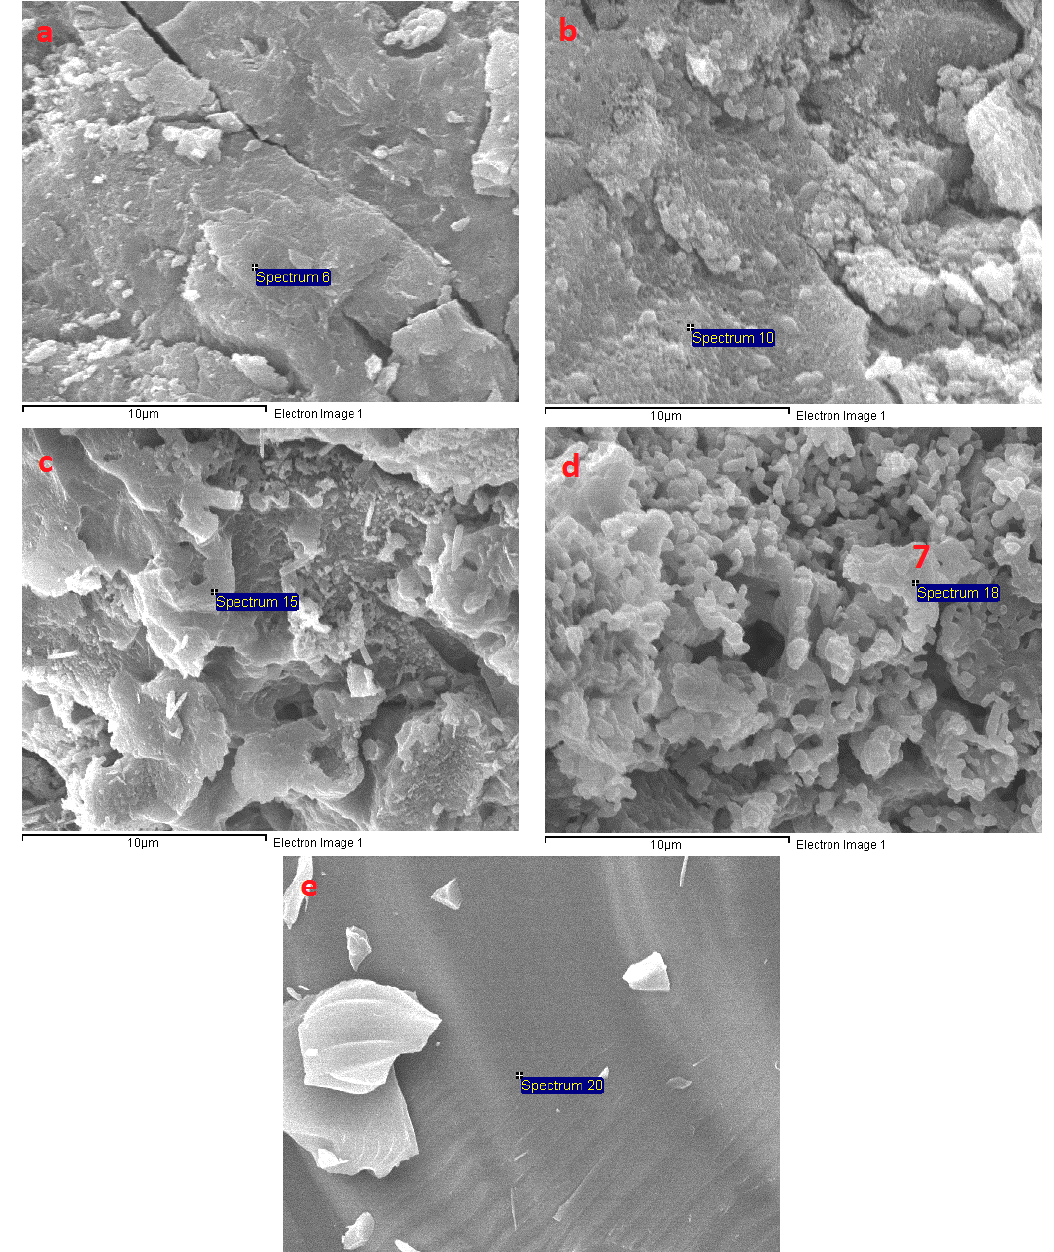
Figure 14. SEM micrographs of fracture surface of A6 at different temperatures: ( a ) 200 ° C ; ( b ) 600 ° C ; ( c ) 800 ° C ; ( d ) 1000 ° C ; and, ( e ) 1200 ° C .